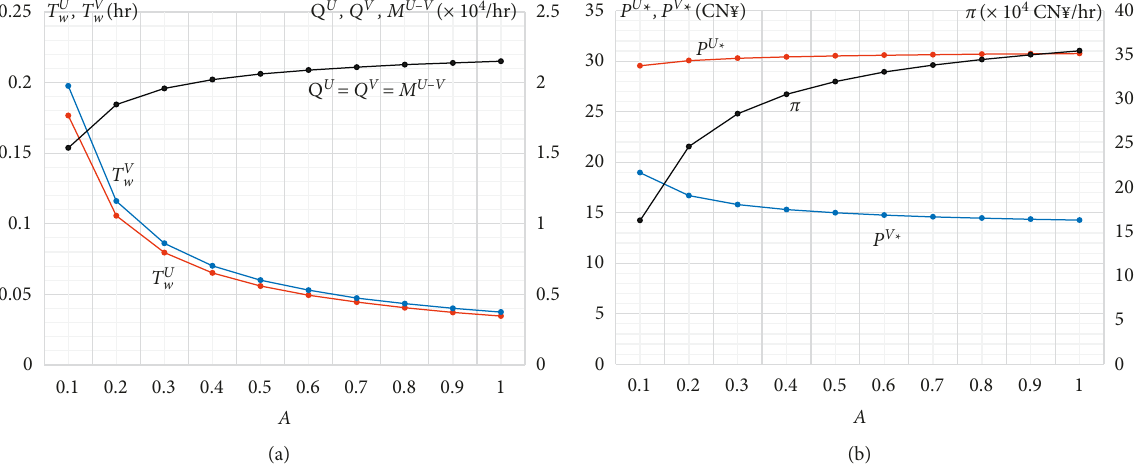
Figure 9: Sensitivity analysis with respect to total factor productivity. (a) Changes in T U and π